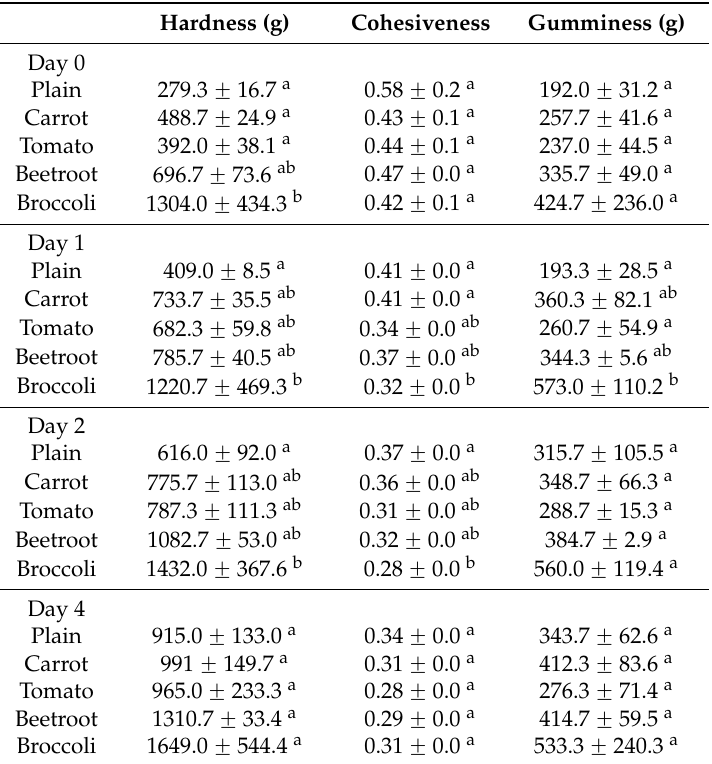
Table 2. Changes in the texture profile of bread during storage.